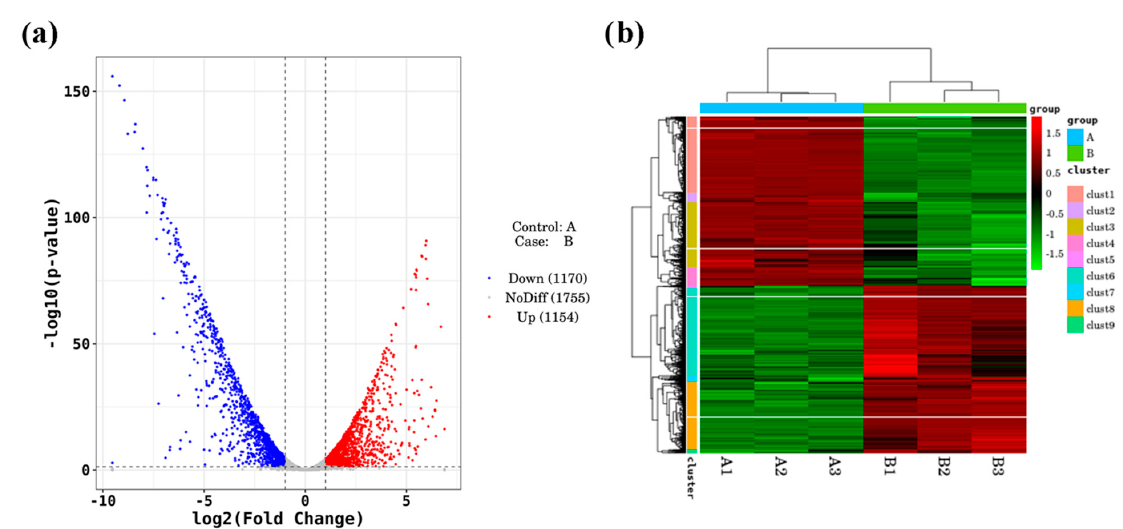
Figure 3. Volcano map and cluster heat map of differentially expressed genes. ( a ) Volcano map; ( b ) cluster heat map.